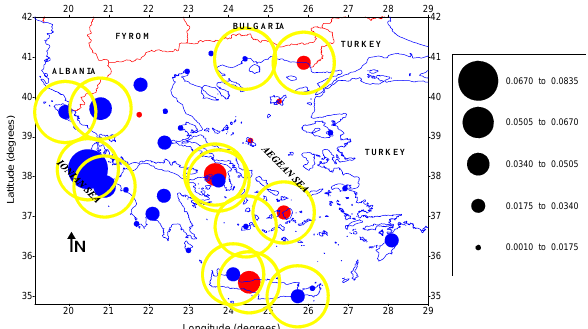
Figure 3 . Spatial distribution of the mean annual RI (mm/h) trends over Greece, during the period 1962-2002. The red and blue proportional circles indicate positive and negative trends, respectively; the yellow rings show statistical significance of the trends at the 95% confidence level.